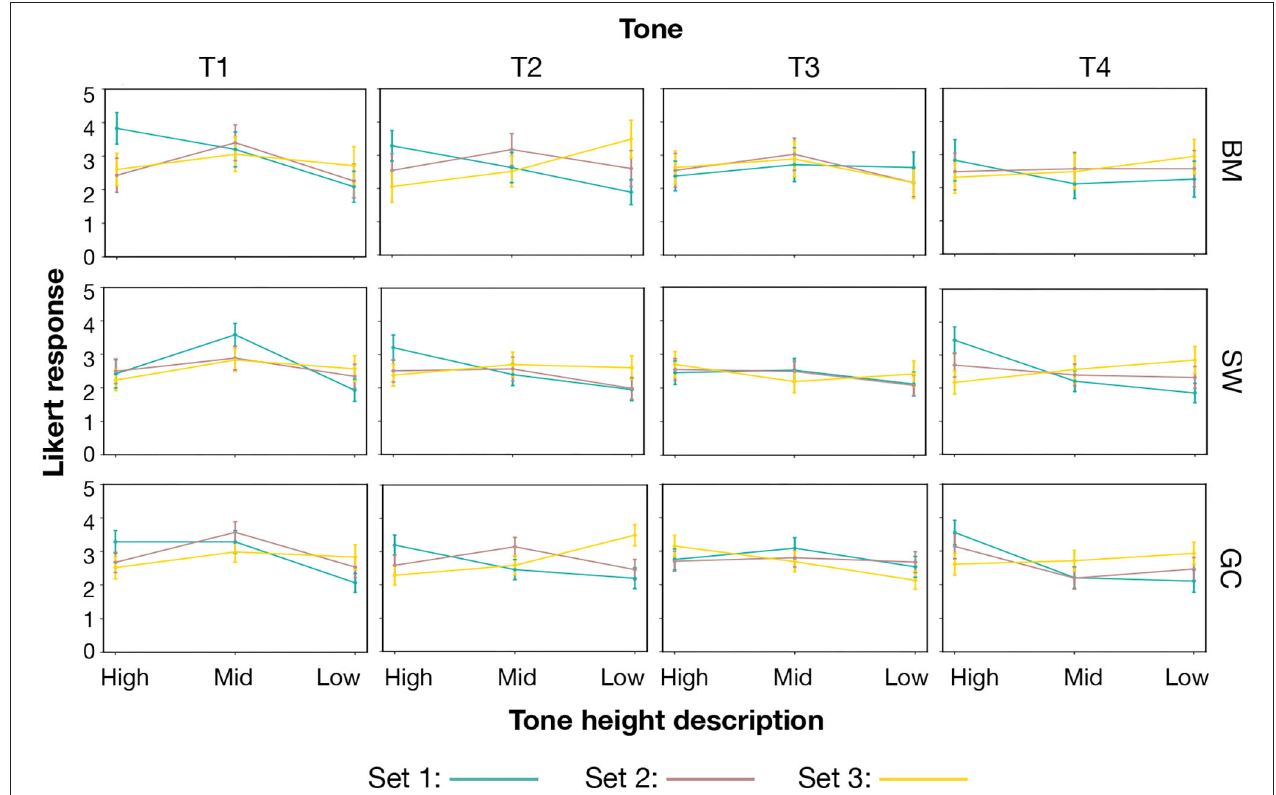
FIGURE 5 | Set curve for height descriptors separated by tone and dialect